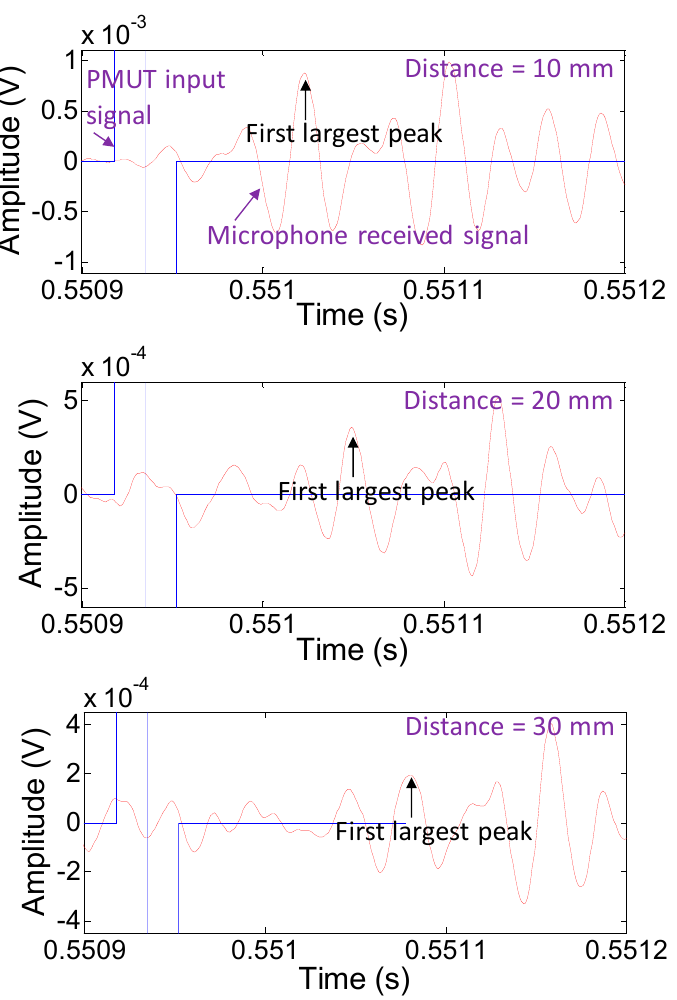
Figure 10. Results of the measured data for different distances after the bandpass filter processing. The first largest peaks as marked in the subplots displays were gradually delayed as the distance increased.